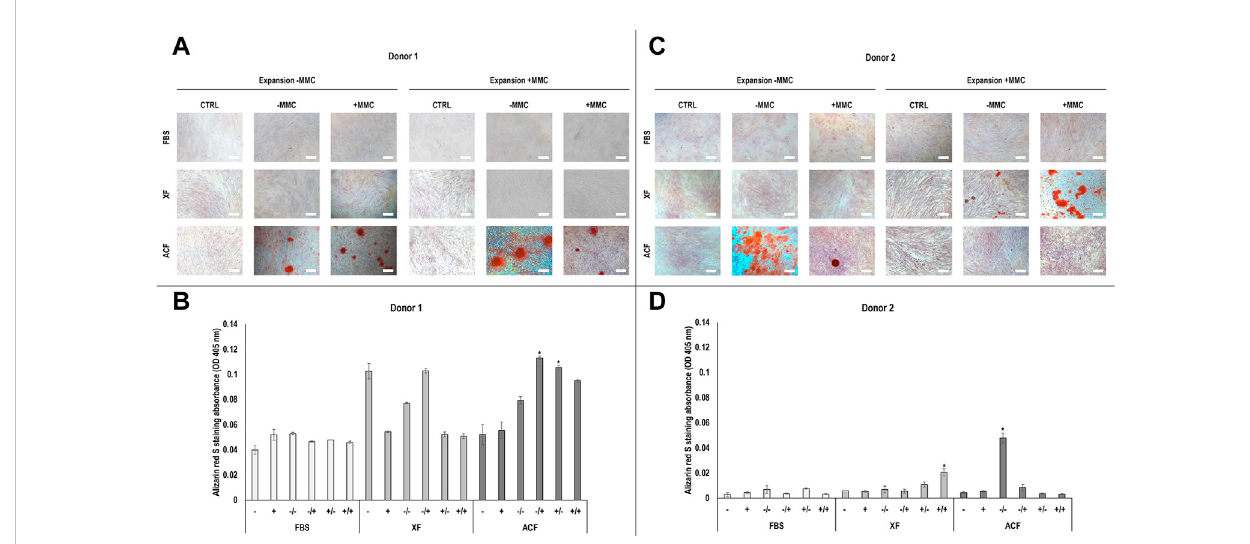
FIGURE 4 Alizarin red staining and corresponding semi-quantitative absorbance analysis of hBMSCs of donor 1 (A, B) and 2 (C, D) , expanded with or without MMCinACF,XFandFBScontainingmedia,anddifferentiatedwithosteogenicinductionmediawithorwithoutMMCsupplementationatp4.Experiments were performed in three technical replicates. # indicates the lowest statistically signi fi cant value ( p < 0.05) at a given time point. * indicates the highest statistically signi fi cant value ( p < 0.05) at a given time point. Scale bars: 100 μ